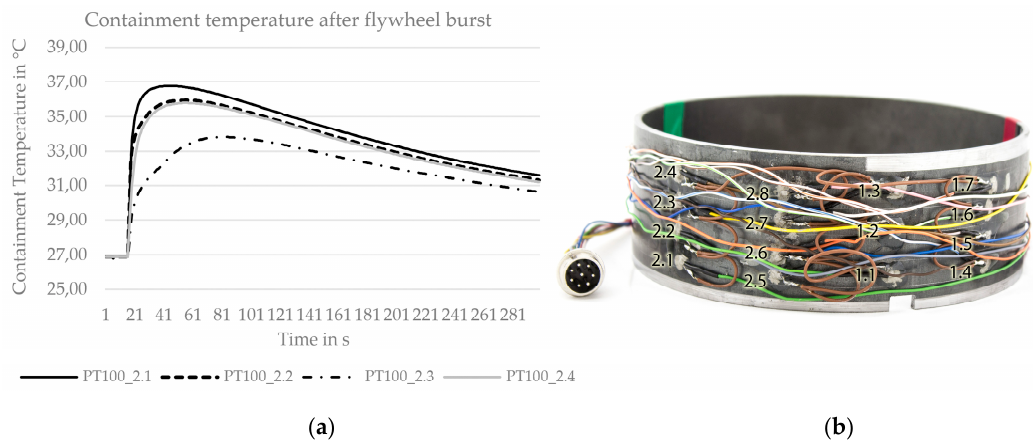
Figure 17. ( a ) Temperature increase after flywheel burst, showing the measurements of sensors 2.1 to 2.4 referring to the pictured containment; ( b ) Burst containment equipped with 15 temperature sensors (PT100).